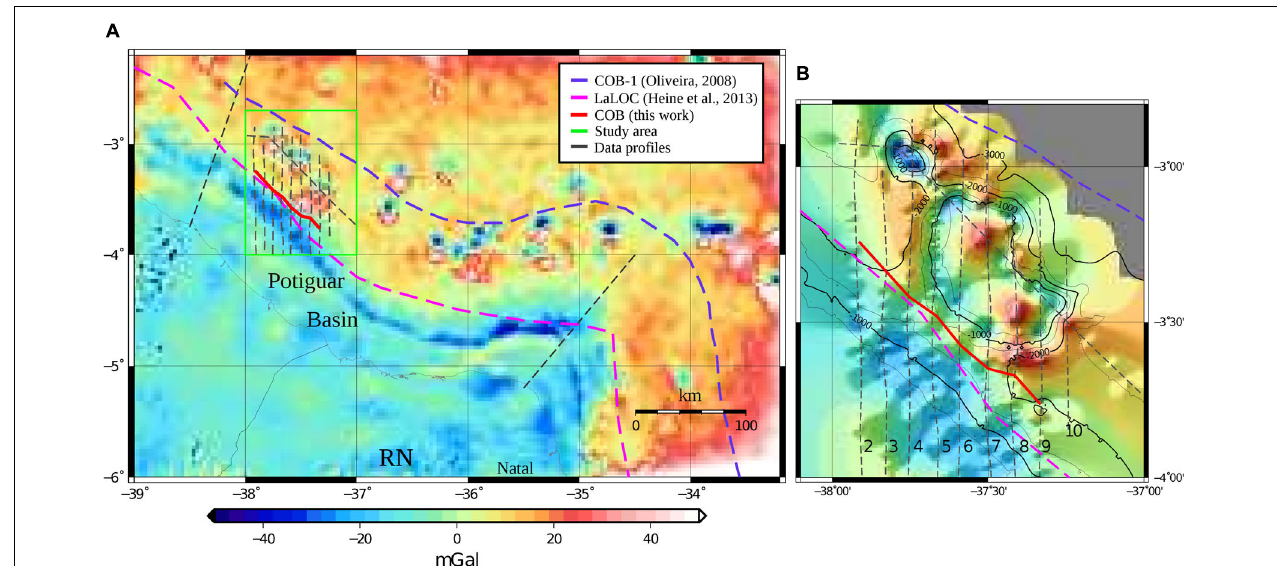
FIGURE 9 | Residual Bouguer anomaly map (A) of the BEM and (B) of the Ceará Plateau area. The same methodology is followed in both data, reinforcing our interpretation about the COB location for an extended area. Dashed profiles #1 to #10 shows the position of bathymetric, gravity and magnetic marine survey. The regional data used to perform the BEM area is from the global model WGM2012 (Bonvalot et al., 2012).